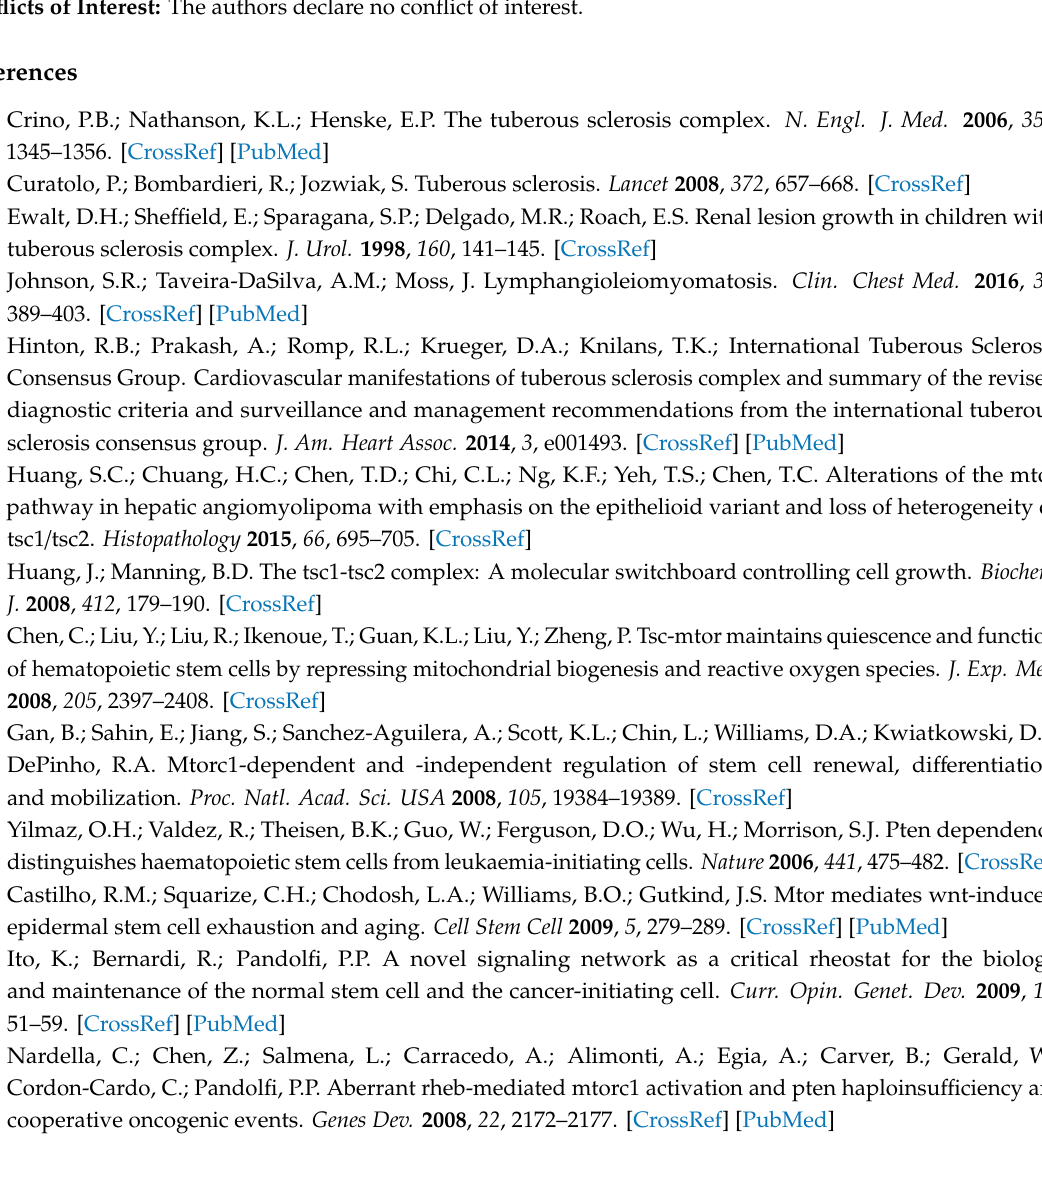
Figure S1: Specificity of Tagln -mediated recombination in LacZ reporter mice; Figure S2. Tsc1 is inactivated in BM-MSCs following Tagln-mediated